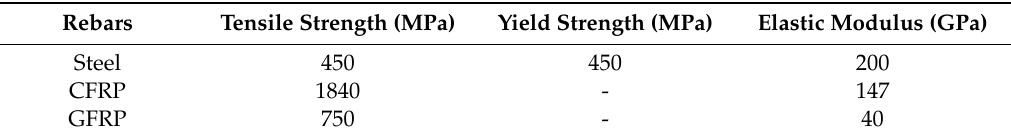
Figure 5. Simply supported beam for numerical investigation, A r and A (cid:48) r are the areas of tensile and compressive rebars, respectively. Table 2. Mechanical properties of rebars.